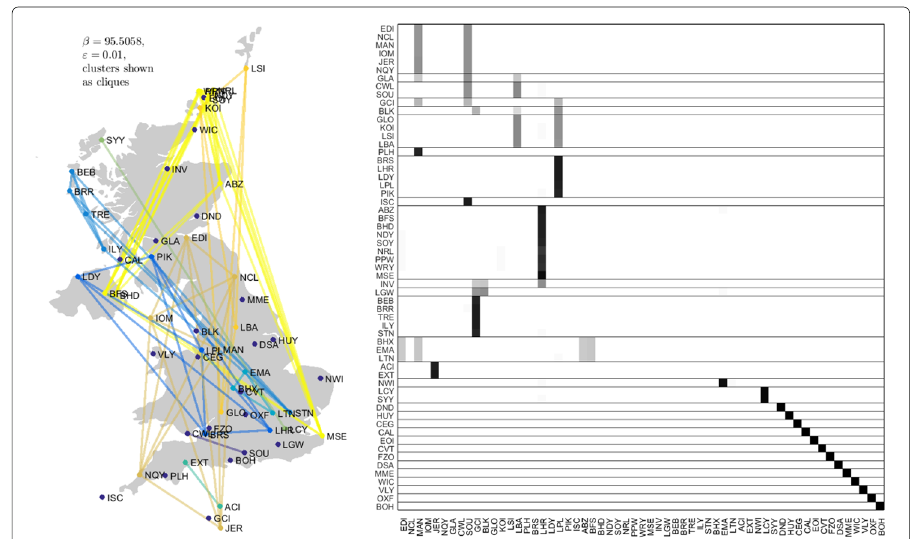
Fig. 10 Clusters from UK flight data for Saturday, 23 October 2010; otherwise as in Fig. 5. Cluster colors only distinguish clusters from each other and do not suggest affinity across days